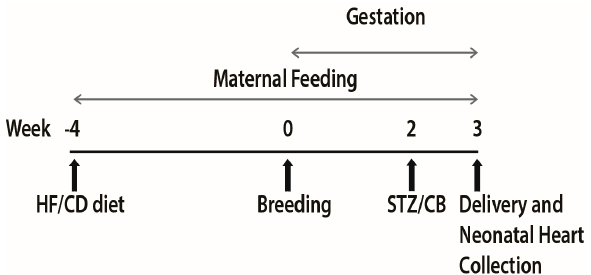
Figure 1. Study timeline. Female rats were randomized into four groups. Two groups were fed high fat diet (HF) and two control diet (CD) for 28 days prior to their breeding and throughout the pregnancy. On gestational day 14, one each of HF and CD group received intraperitoneal injection of Streptozotocin (STZ, 65 mg/kg) and the remaining two received citrate buffer (CB) as a control. Pups were normally delivered on gestational day 22 and sacrificed for heart collection.